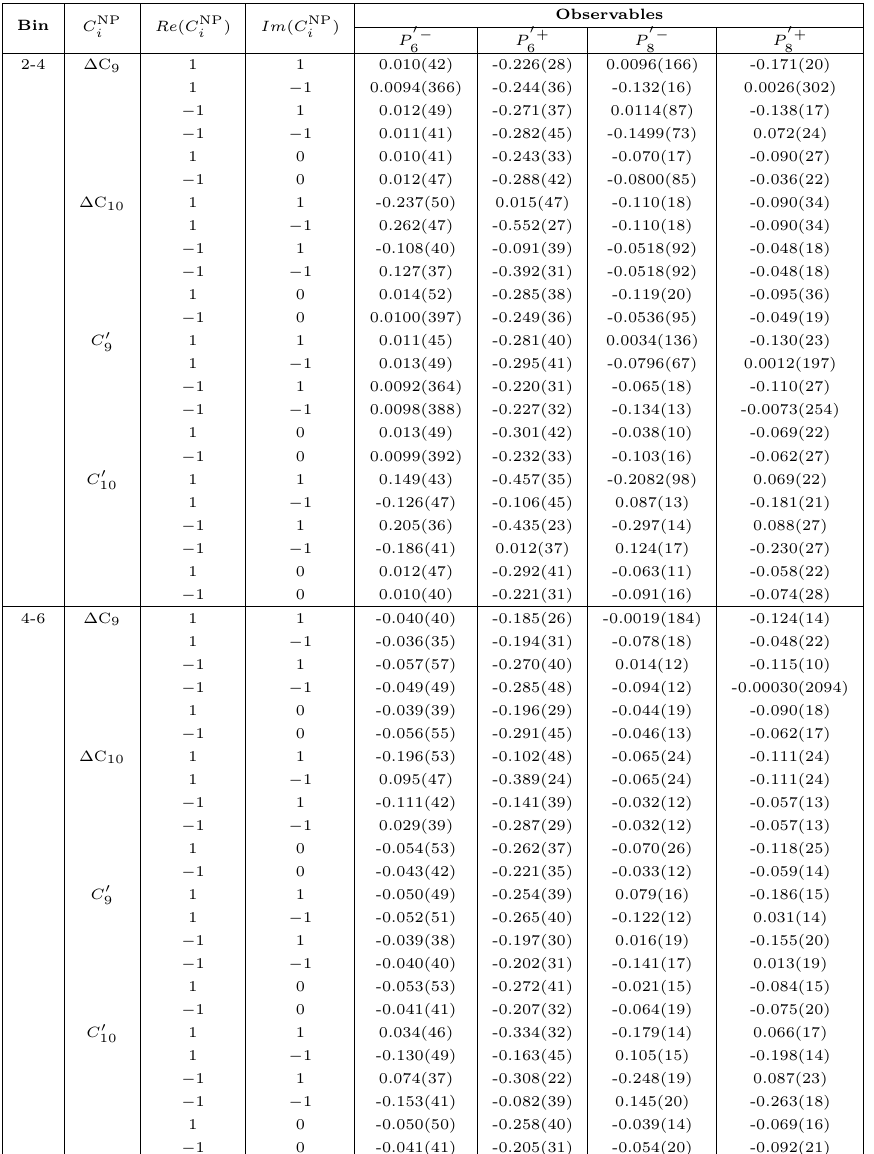
for the q 2 bins 2 − 4 9 , 10